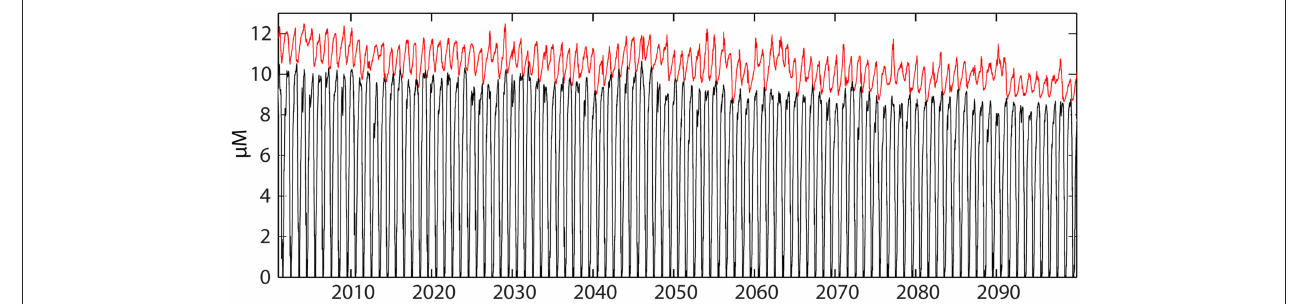
FIGURE 14 | Variation of simulated nitrate concentrations ( µ M) near the bottom between 300 and 370m (red) and at the surface (black) in the southern Barents Sea during this century (A1B).